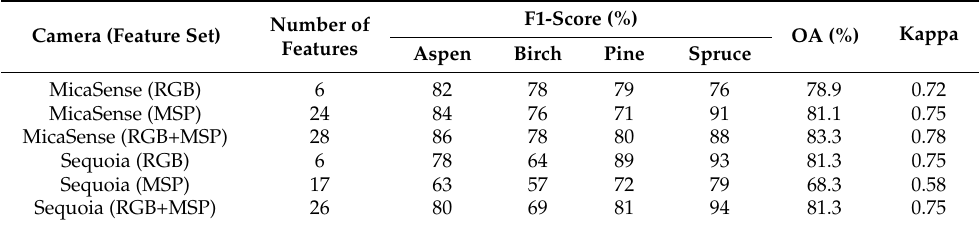
Table 4. Accuracy assessment of the 4-class classification model. MSP = spectral features extracted from multispectral mosaics, RGB = spectral features extracted from PPC, OA = overall accuracy. Camera (Feature Set)